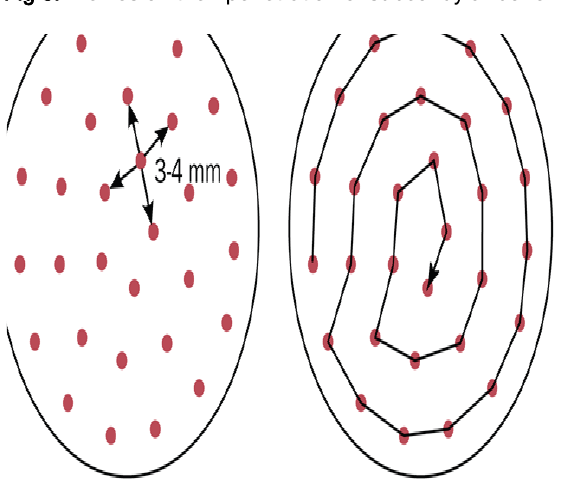
Fig 5:The lesion then penetration of subcondylar bone